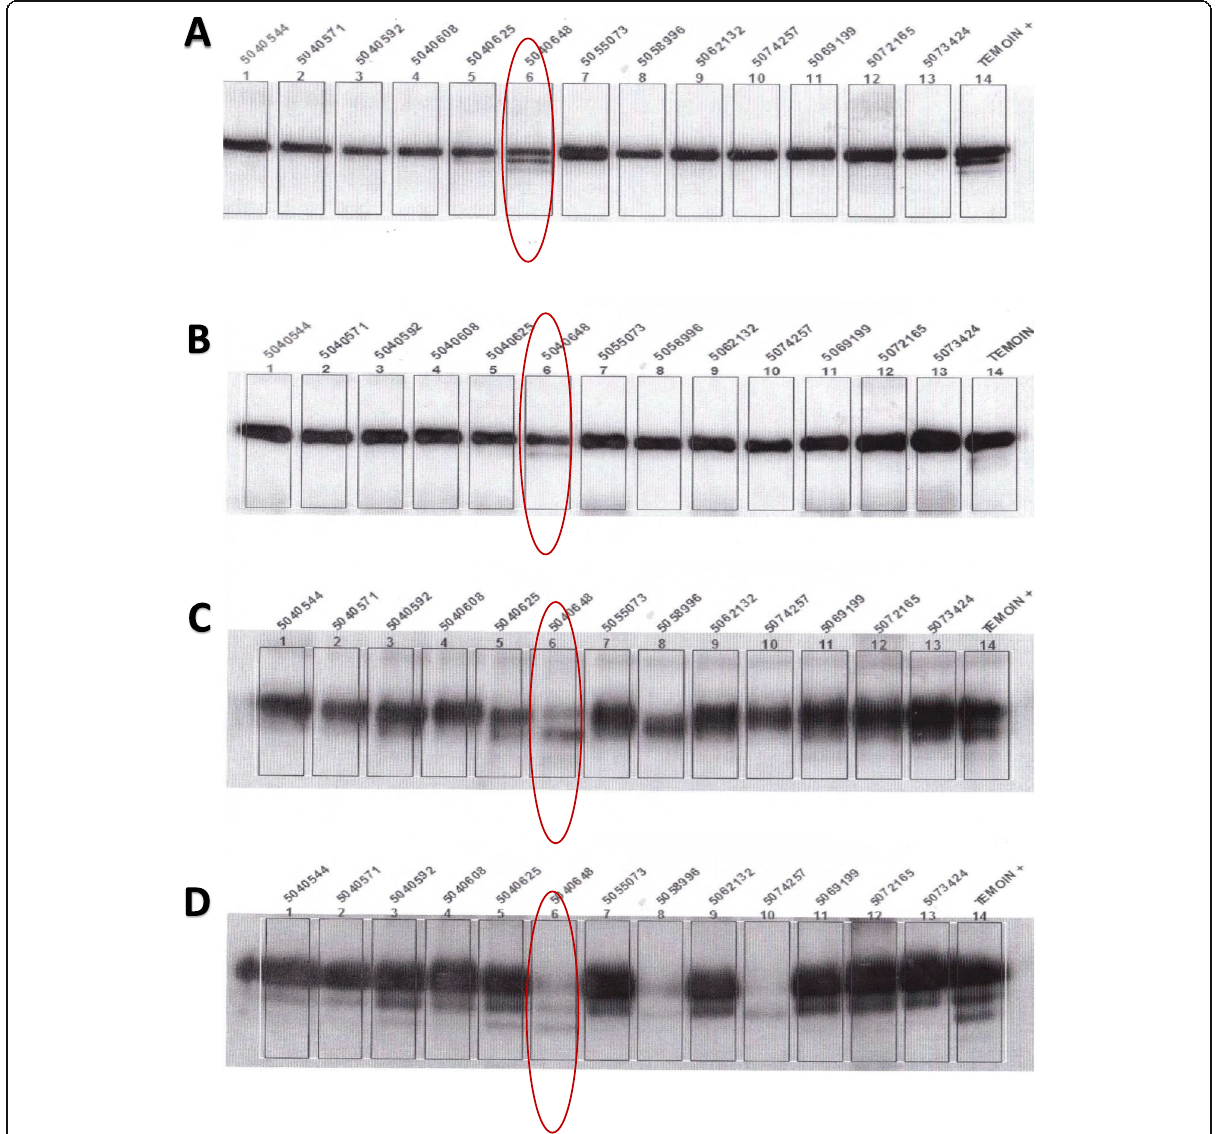
Fig. 2 Separation of a transferrin, b α -1-antitrypsin, c α -1-acid glycoprotein and d hepatoglobin for N-glycan analysis of 13 subjects using WB